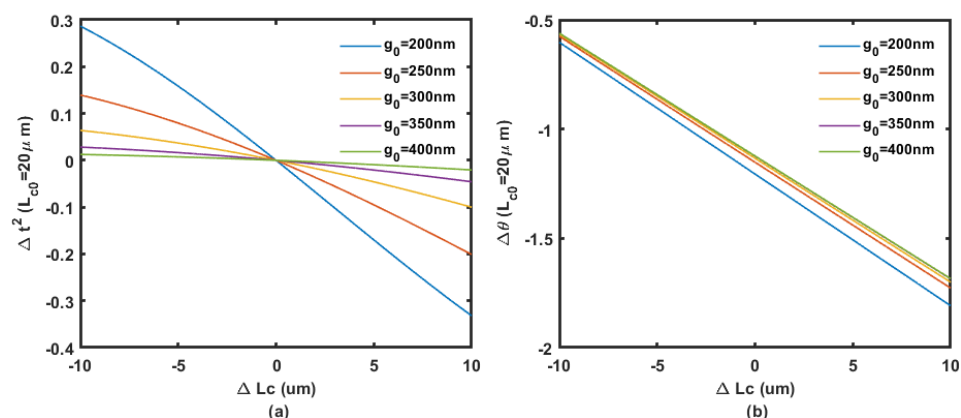
Figure 6. Coupling ( a ) and phase ( b ) change regarding the displacement in coupling length with 20 µ m initial length at different coupling gaps from 200 nm to 400